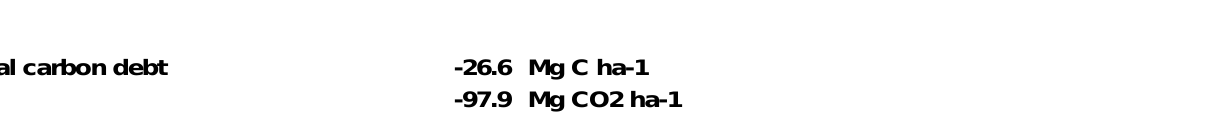
Table A2.2. continued Carbon debt calculation of the Kubu Raya, West Kalimantan, Indonesia case